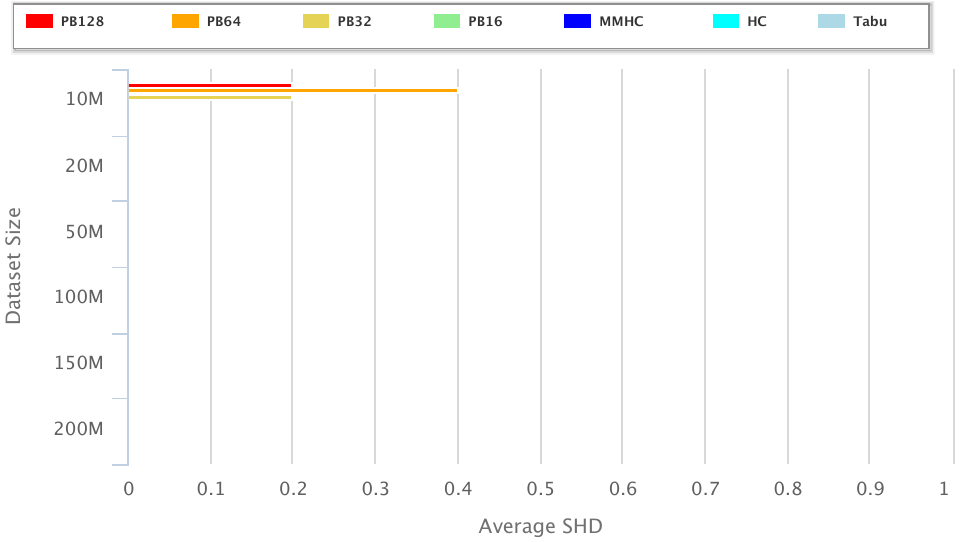
Figure 14. Child Dataset Accuracy